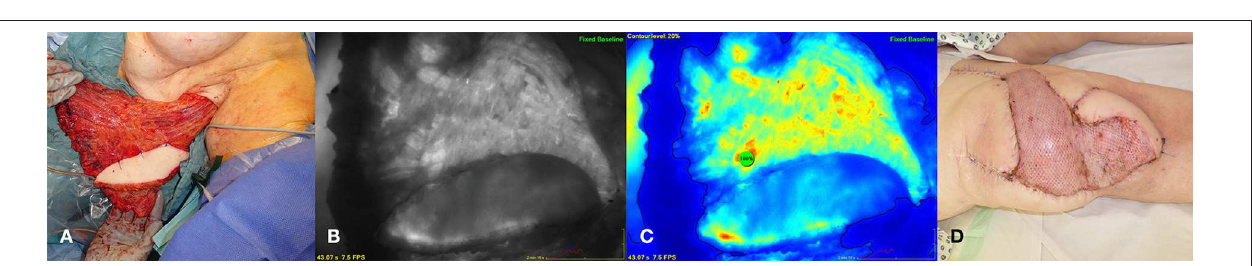
FIGURE 4 | Myocutaneous latissimus dorsi flap for coverage of a defect at the right knee. (A) Latissimus flap after complete harvesting at the left axilla. (B) (middle left) ICG angiography revealing mal-perfused flap areas at the periphery. (C) (middle right) Color mode and contour level at 20% in relation to a reference point of maximum fluorescence within the flap. (D) (right) Flap after inset and anastomosis at the right